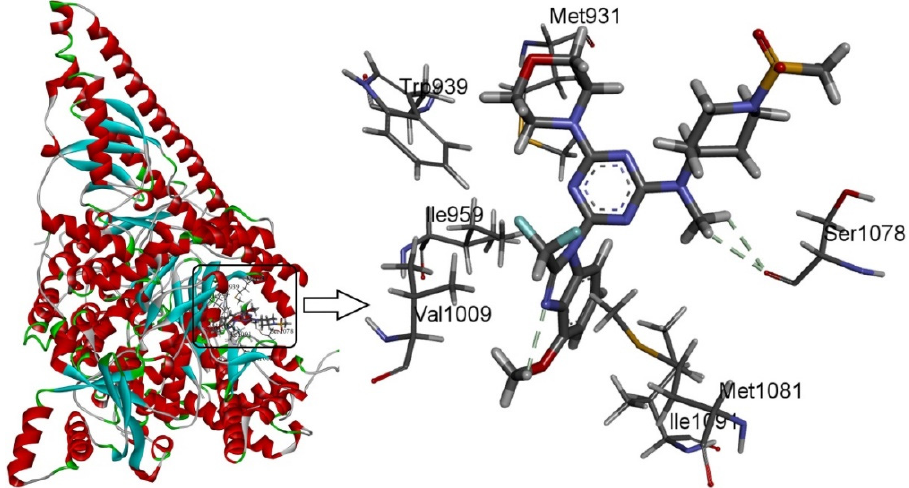
Figure 5. Docking of the representative ligand compound 29 into the binding site of PI3K α . Ligands and the important residues of the binding interaction are depicted by stick-and-line models.